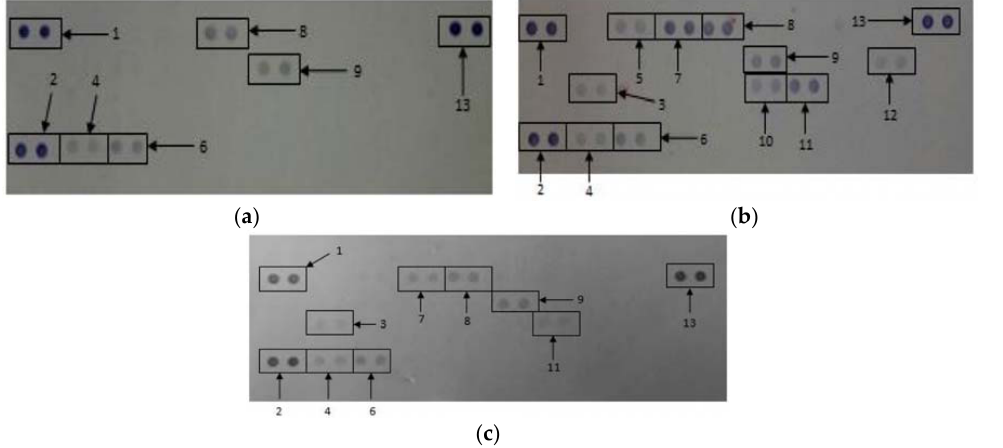
Figure 7. The effects of CDs on whole blood cells. Cells were incubated with ( a ) media only; ( b ) media and LPS; ( c ) 500 μ g/mL CDs in the absence of LPS. Cytokines/chemokines that were detected were allocated numbers: 1, 2, and 13 are reference spots; 3—IL-1ra; 4—macrophage migration inhibitory